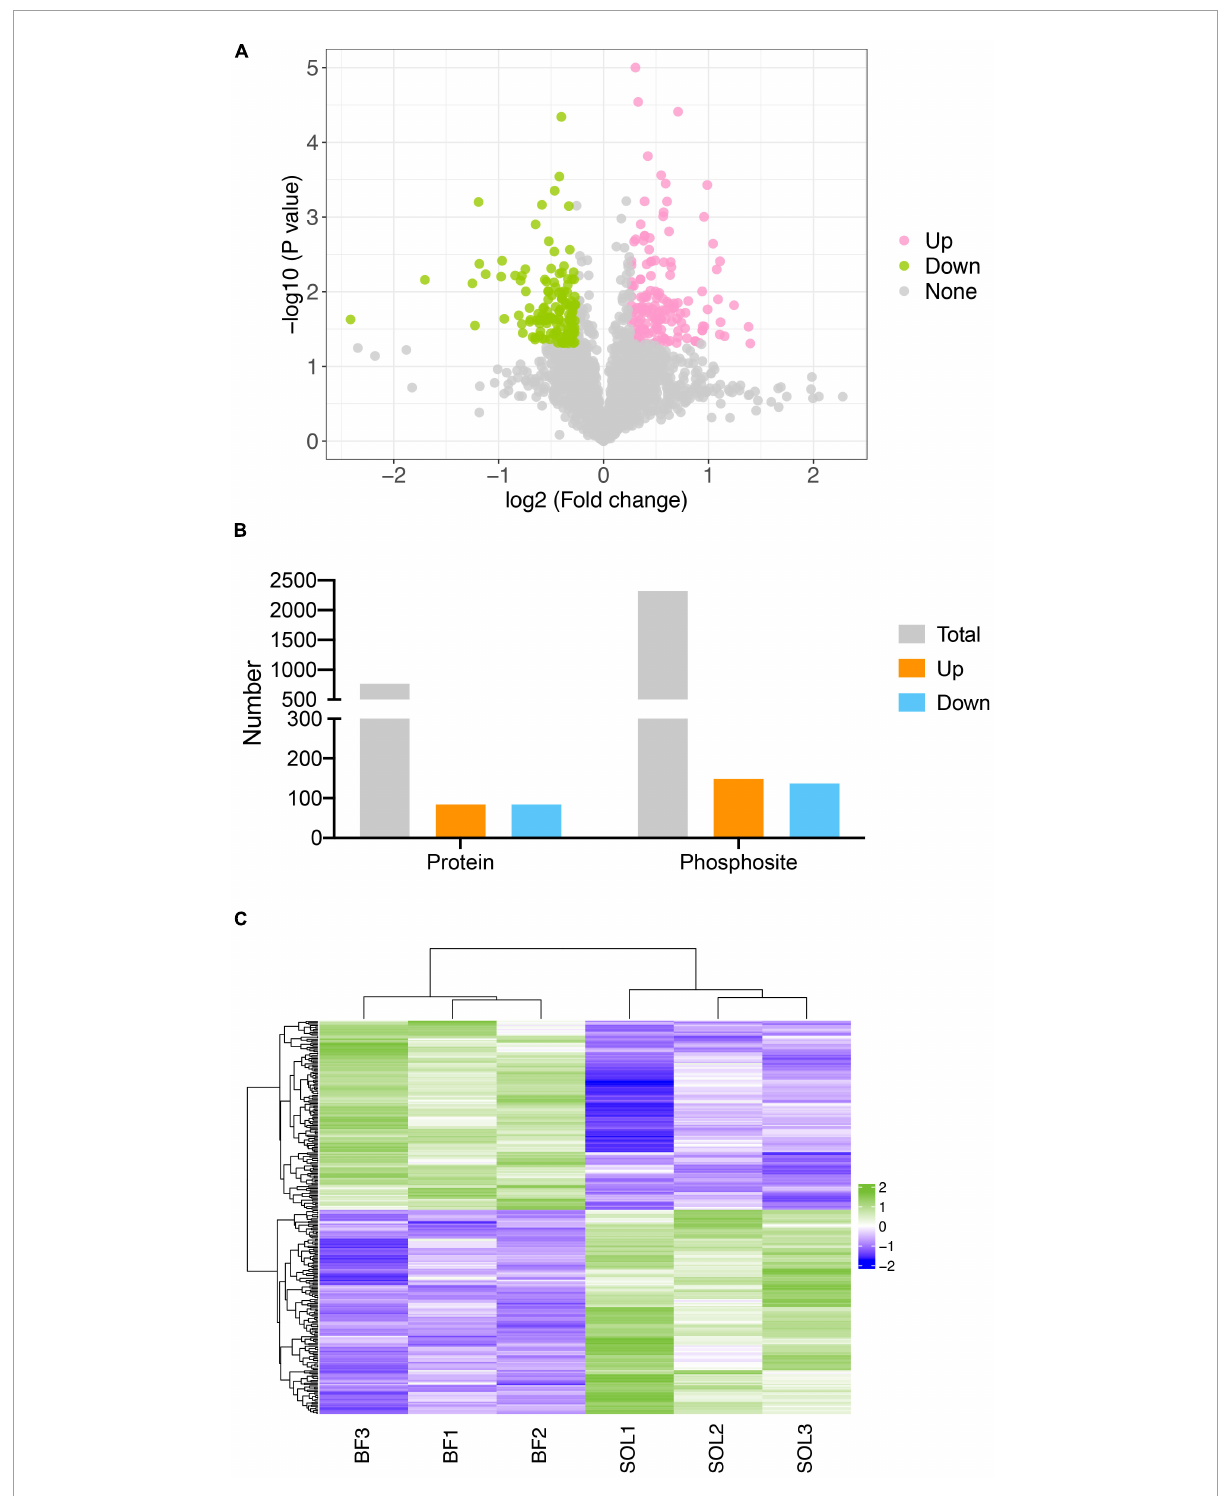
FIGURE4 Identification of differentially expressed phosphorylation sites (DEPSs) in BF and SOL muscle tissue. (A) Volcano plot showing DEPSs in BF vs. SOL. DEPSs which are significantly up-regulated or down-regulated are indicated in pink and green dots. DESPs without statistical significance are indicated by gray dots. (B) Number of total, up- and down-regulated DEPSs and their corresponding phosphorylated proteins. (C) Heat map showing the abundance patterns of the DEPSs in BF and